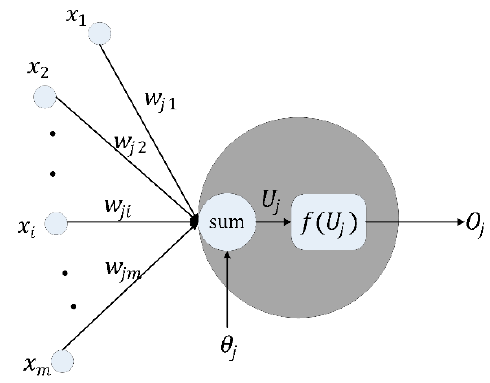
Figure 4. A neuron of an MLP